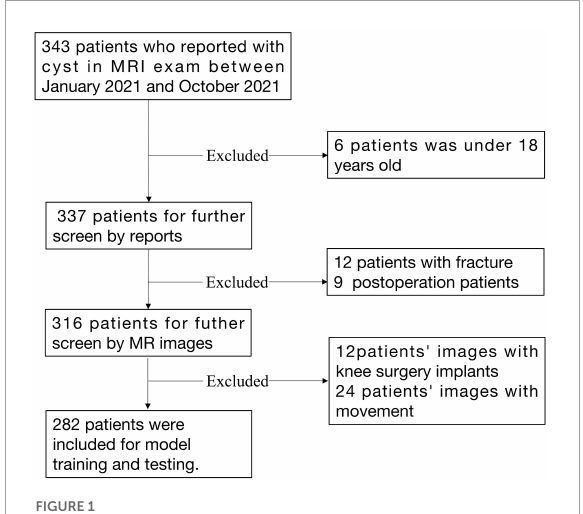
FIGURE1 Flowchart of subject inclusion/exclusion and data